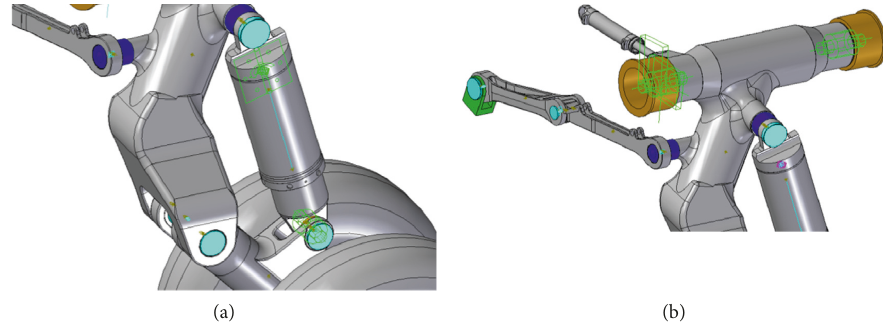
Figure 6: Revolute joints between: (a) main fitting, trailing arm, and shock absorber; (b) main fitting and support